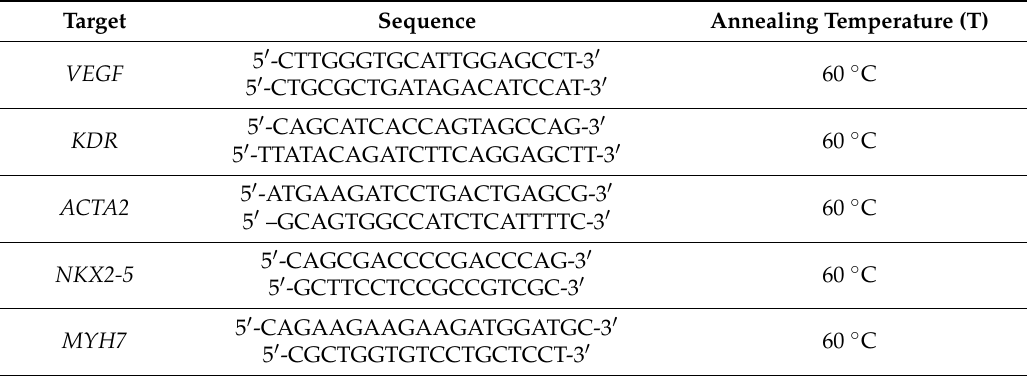
Table 1. Primers used for real-time reverse transcriptase polymerase chain